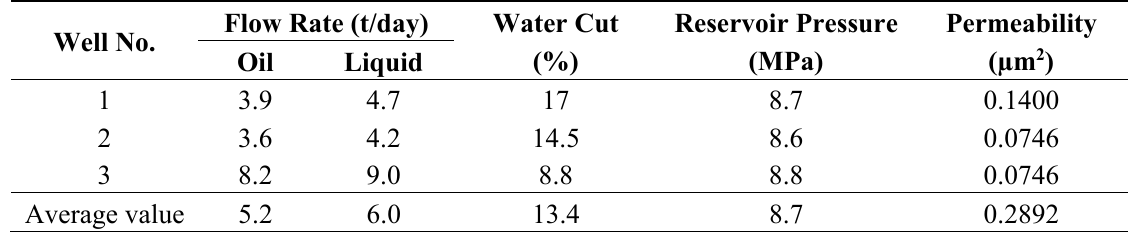
Table 5. Input parameters of the Field number 1 for hydrodynamic modeling. Well No.